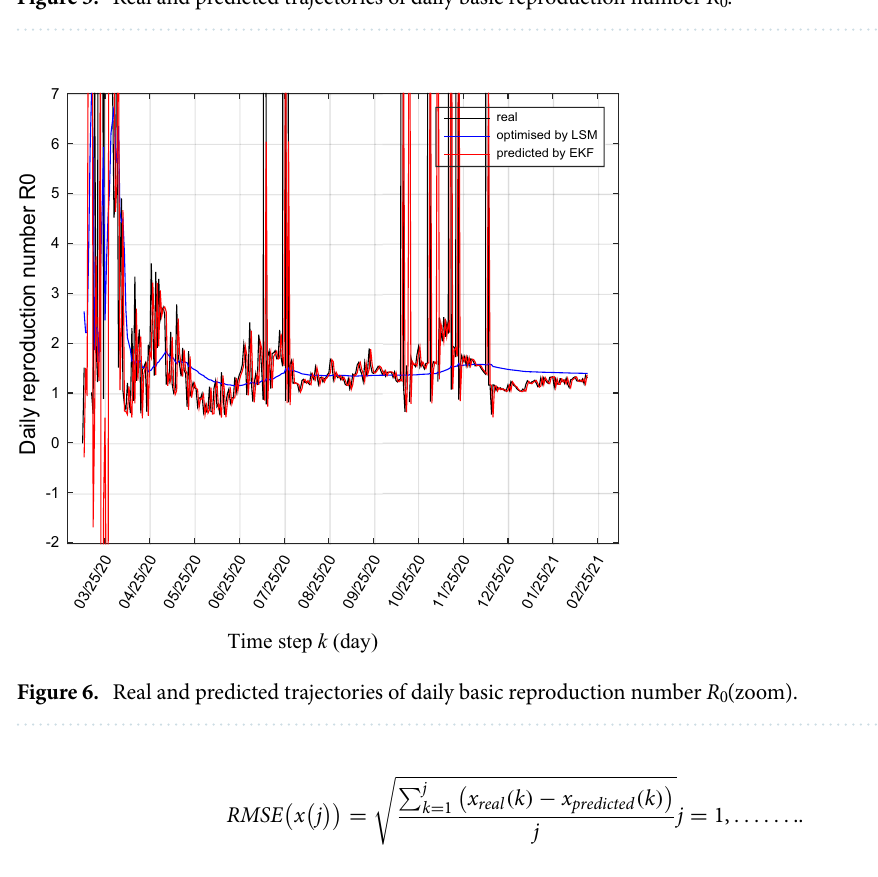
Figure 5. Real and predicted trajectories of daily basic reproduction number R 0 .